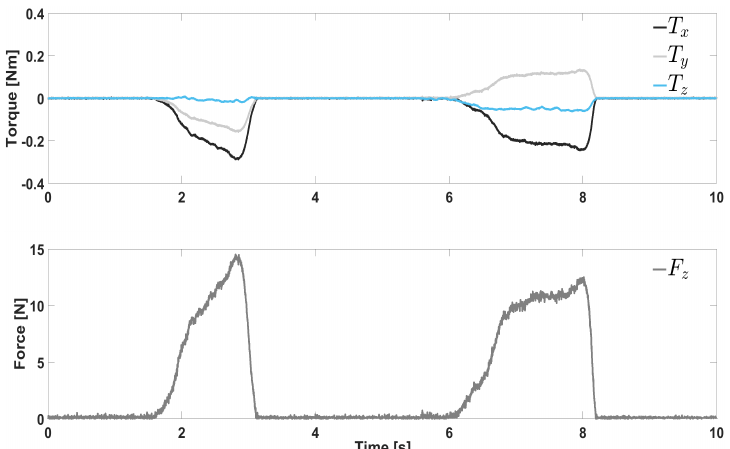
Figure 9. Normal force and torques measured by the F/T when pressing on P1 ( left ) and P2 ( right ).